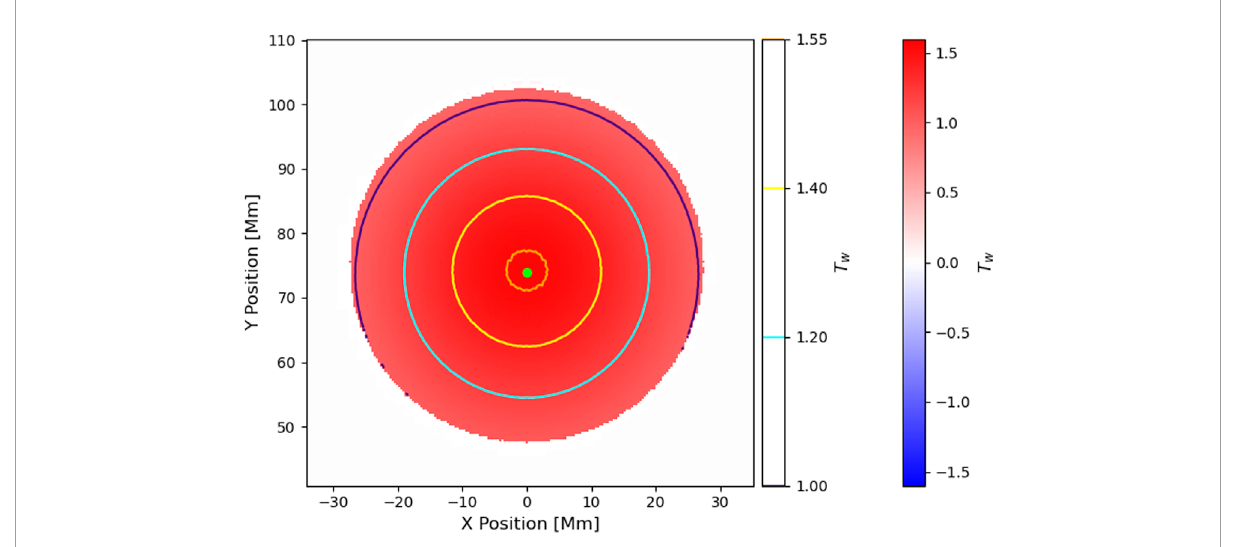
FIGURE 1 Output from the axis locating step, showing a high-resolution plot of T w with contours of T w overlaid. A lime dot indicates the centre of the highest contour, taken forward as the flux rope